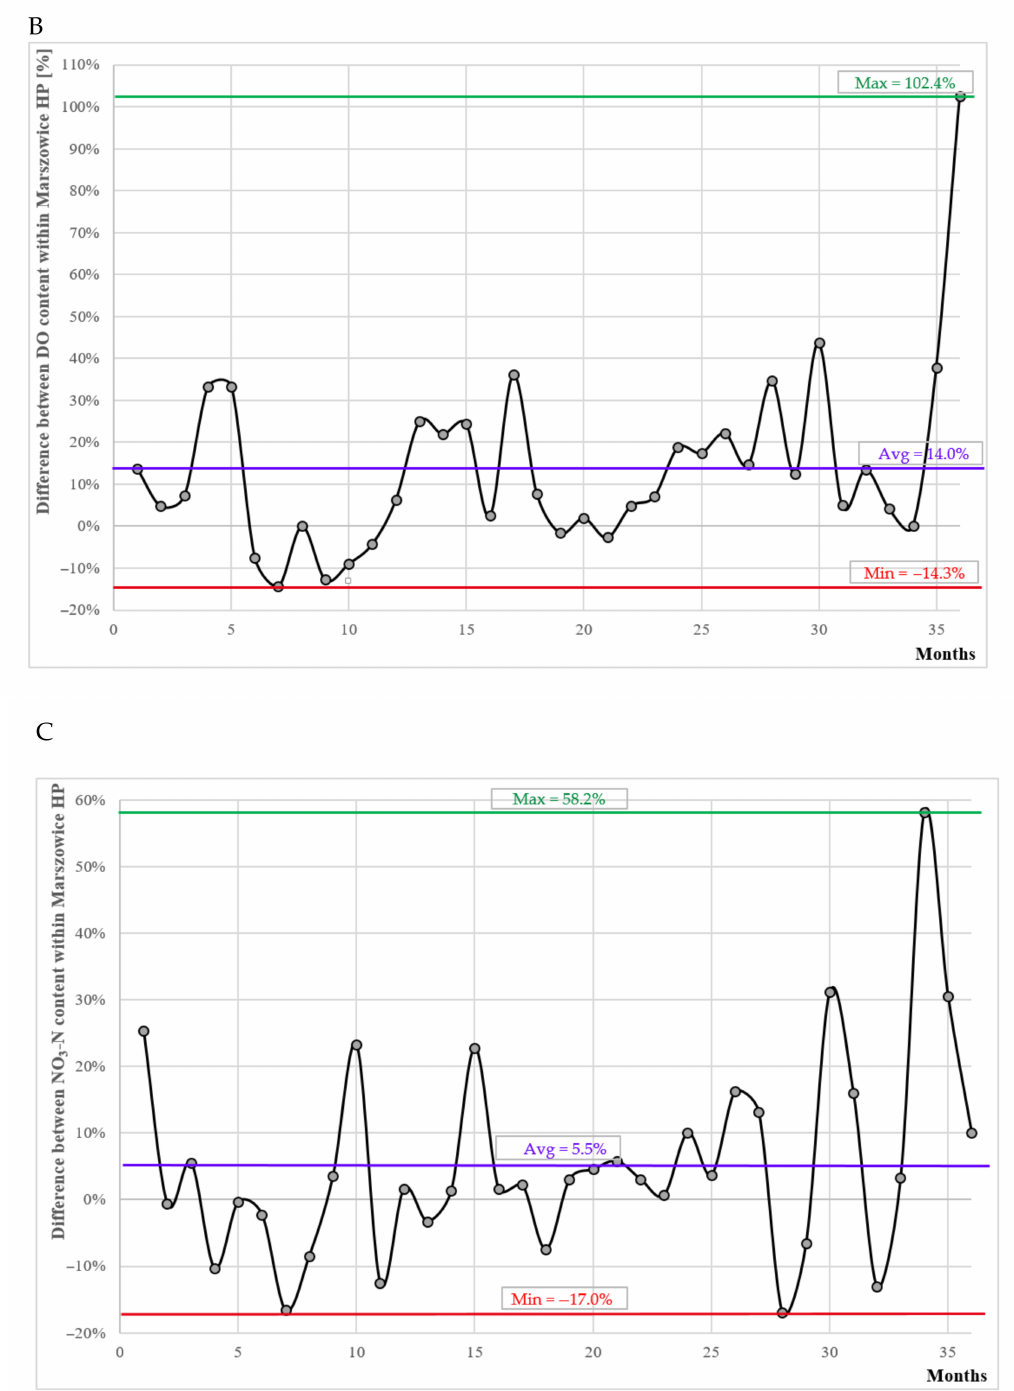
Figure 9. Percentage change in selected statistically significant physicochemical parameters with an average change greater than 5%: ( A ) ammonium nitrogen (NH 4 -N), ( B ) dissolved oxygen (DO), and ( C ) nitrate nitrogen (NO 3 -N) below